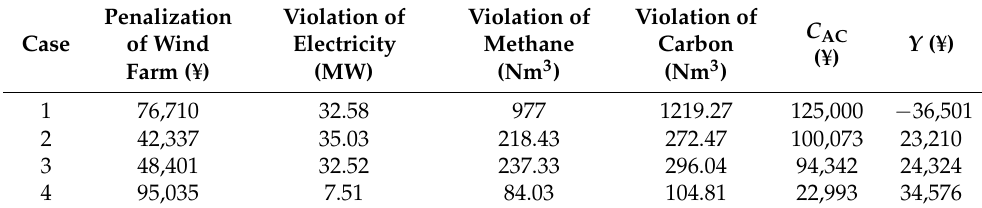
Figure 6. Scheduling plans of typical wind power curve k 0 and the scheduling results of Case 4. Table 5. Performance of adopting smart contract in different